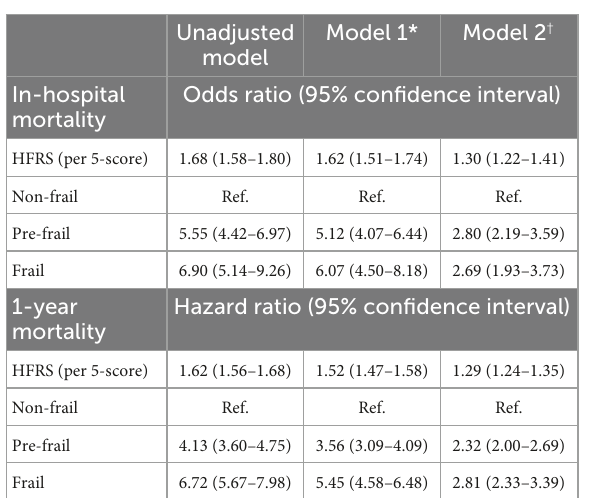
TABLE 2 Associations between frailty and in-hospital and 1-year mortality.